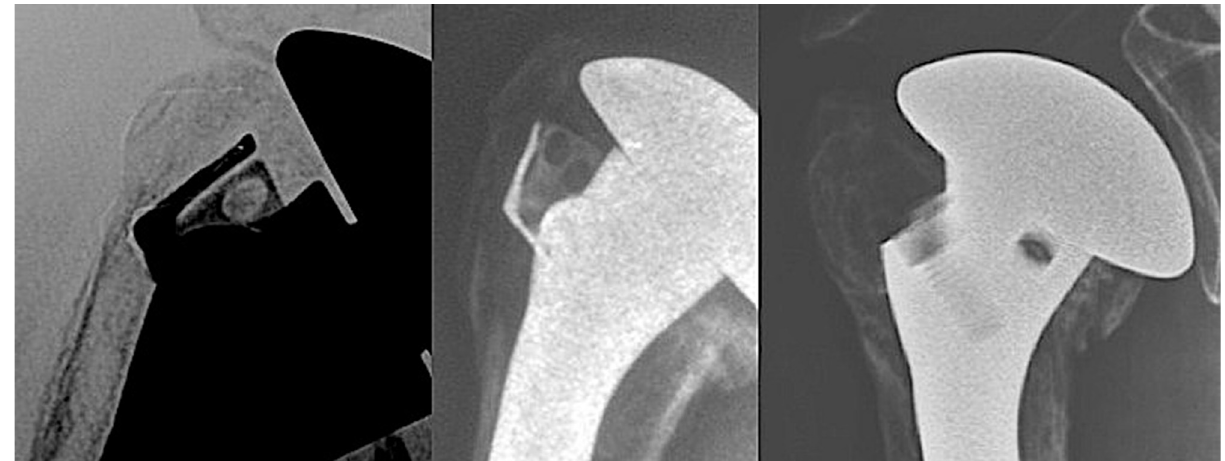
Figure 4. Three examples of tuberosity consolidation after 6 months obtained with the combination of looped thread grafts and OMS (cid:4) . When tuberosities have a volume of bone which seems to be sufficient, OMS is not mandatory.